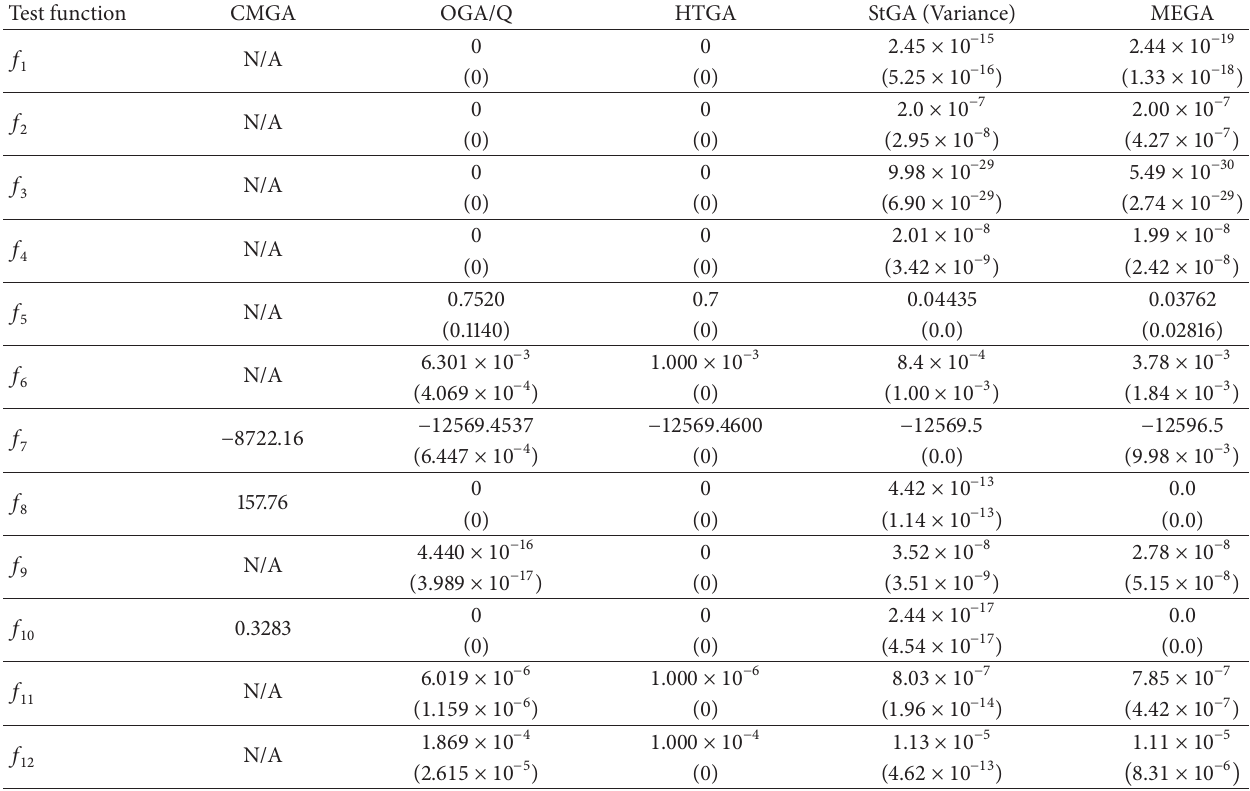
Table 5: Comparison of the mean best value (and Std Dev) with other GAs.